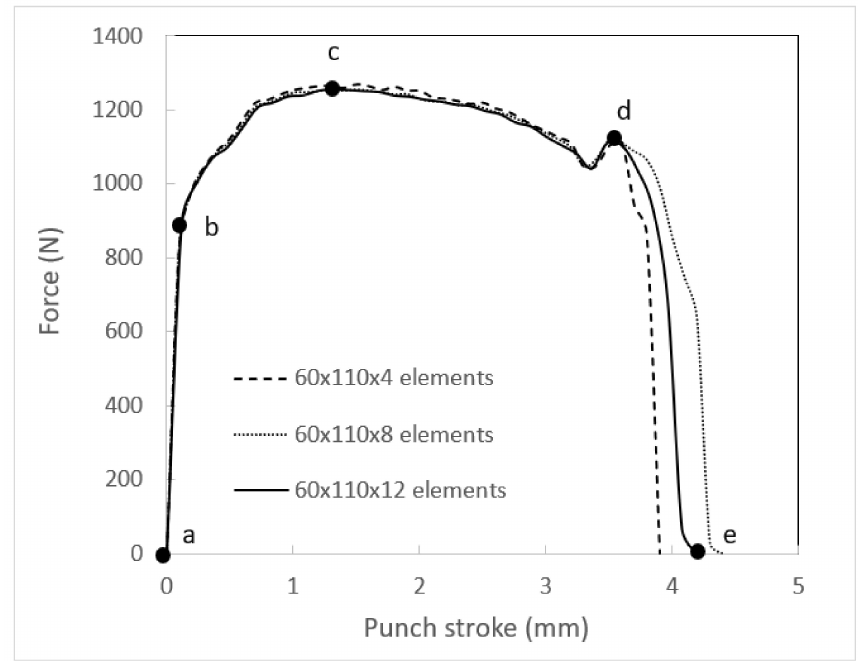
Figure 4. Effect of mesh sensitivity on force-displacement